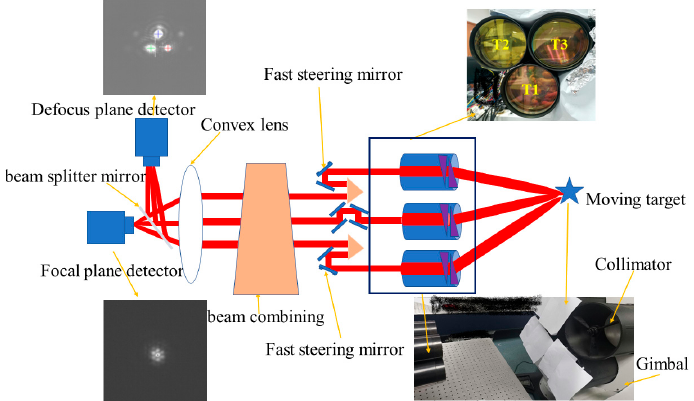
Figure 1. The Fizeau directly-imaging sparse aperture telescope platform.